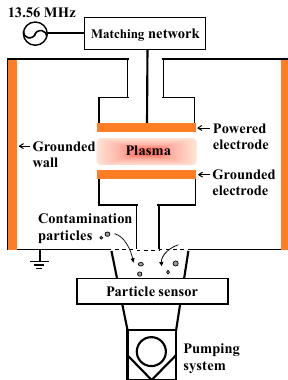
Figure 1. Schematic diagram of the capacitively coupled plasma etching system. A specimen was placed in the powered electrode, grounded electrode, and grounded wall.